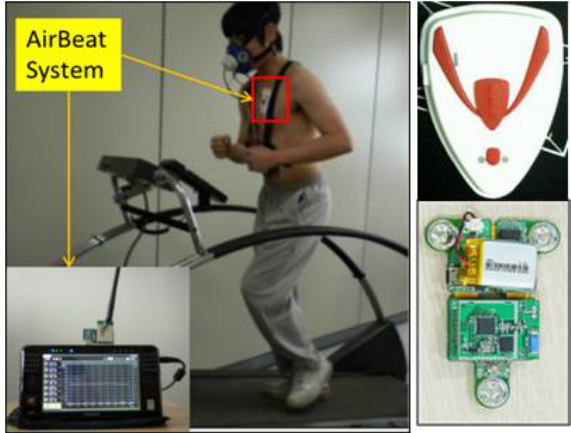
Figure 1. Patch-type sensor module and Cosmed K4b 2 gas system during treadmill running.